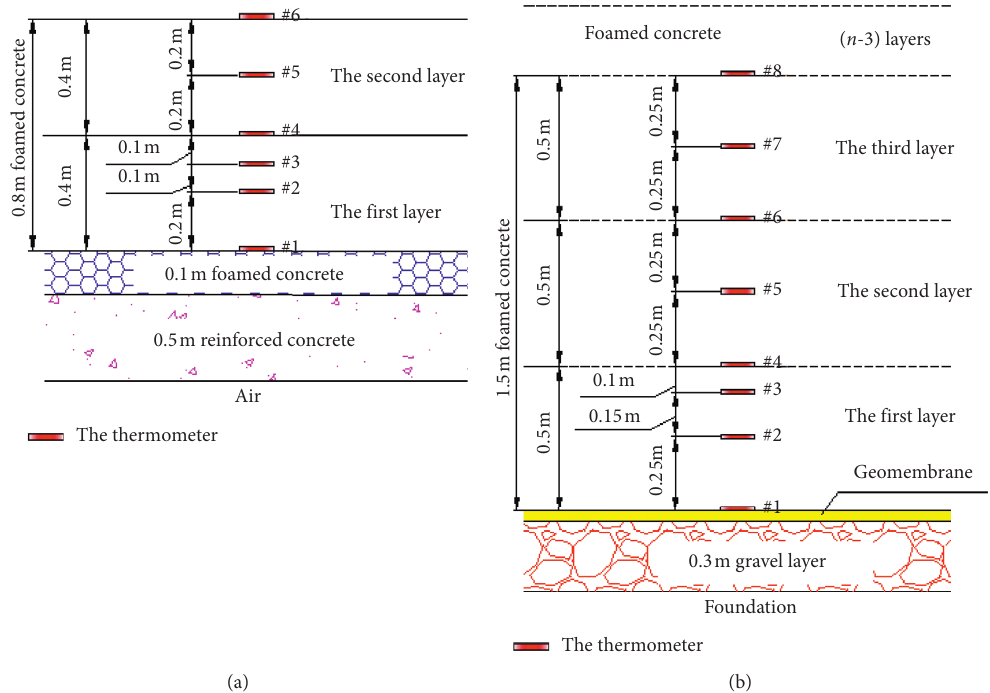
Figure 15: Layout of the components in (a) project 1 and (b) projects 2, 3, and 4.